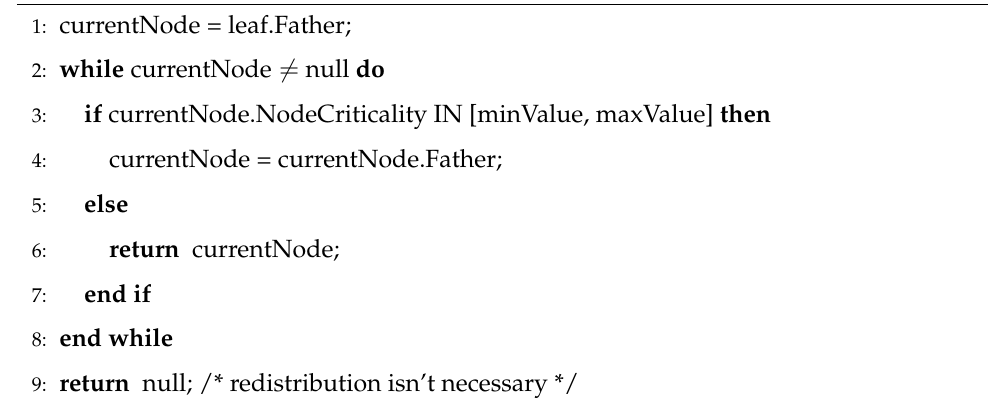
Algorithm 4 CheckNodeCriticality(BinaryNode